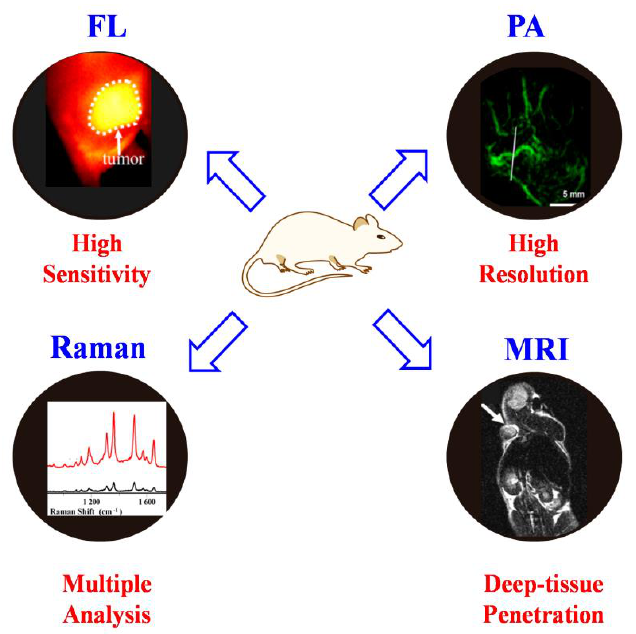
Figure 10. The advantages of each imaging modality.